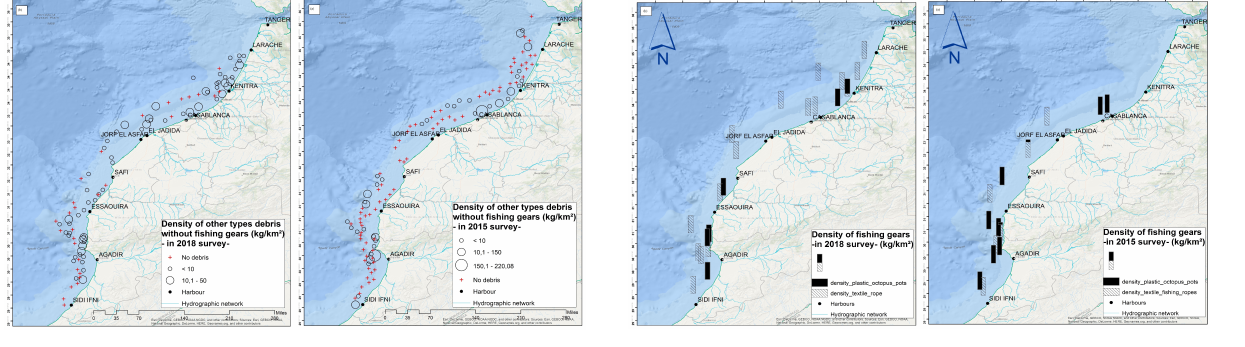
Figure 9. The spatial distribution of land-based debris in the Seafloor of the North and the Centrale part of the Moroccan Atlantic in both surveys: (a) :2015, (b): 2018.